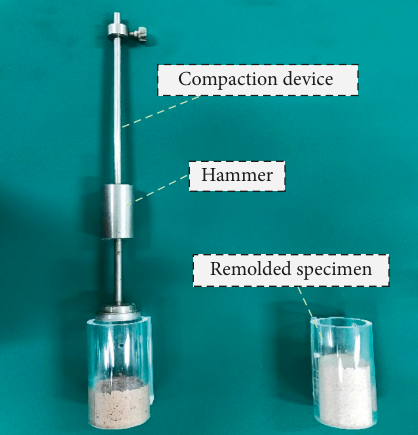
Figure 1: Manufacturing process of the remodelled soil Table 1: Physical parameters of the remodelled rare earth ore sample.